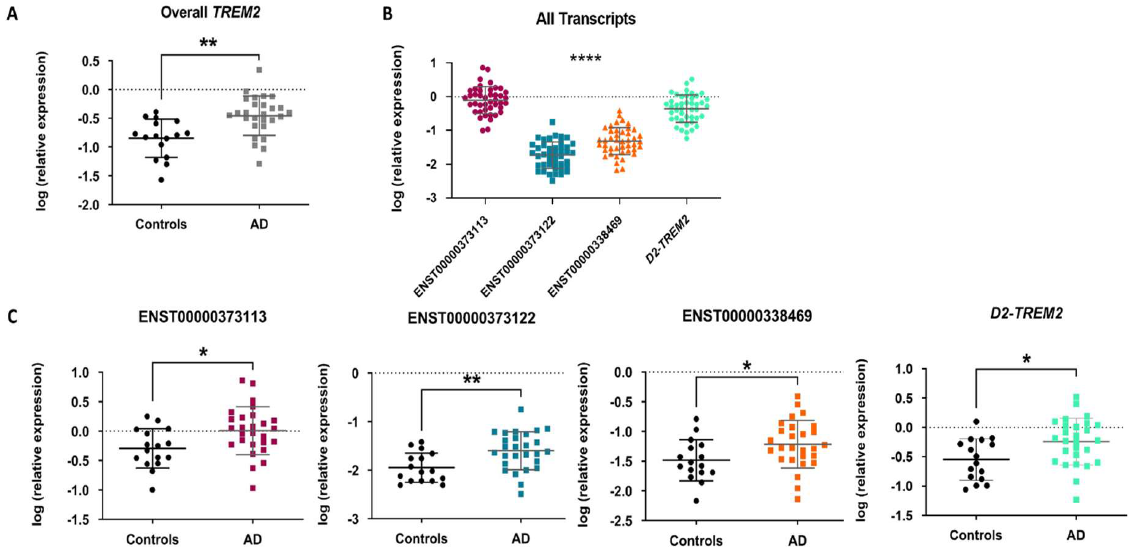
Figure 3. Overall and transcript-specific TREM2 expression levels. ( A ) Dot-plot represents the expression of TREM2 mRNA in AD samples and controls. ( B ) Dot-plot shows the expression of TREM2 transcripts variants in entorhinal cortex. Vertical lines represent the SE. ( C ) Dot-plot represents the expression level of each TREM2 transcript variant in entorhinal cortex of AD patients when compared to controls. ( C ) * p -value < 0.05, ** p -value < 0.01, and **** p -value <